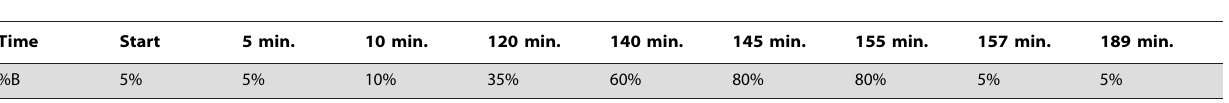
Table 5. LC gradient for on-line reverse phase